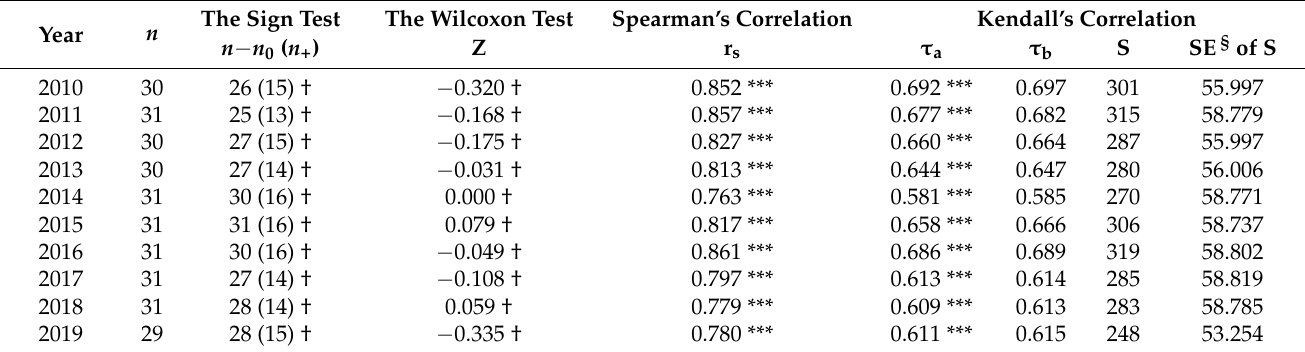
Table 7. Results of the sign test, Wilcoxon test and Spearman’s and Kendall’s correlation tests for HLY ranks for the total population and the older subpopulation in 2010–2019.